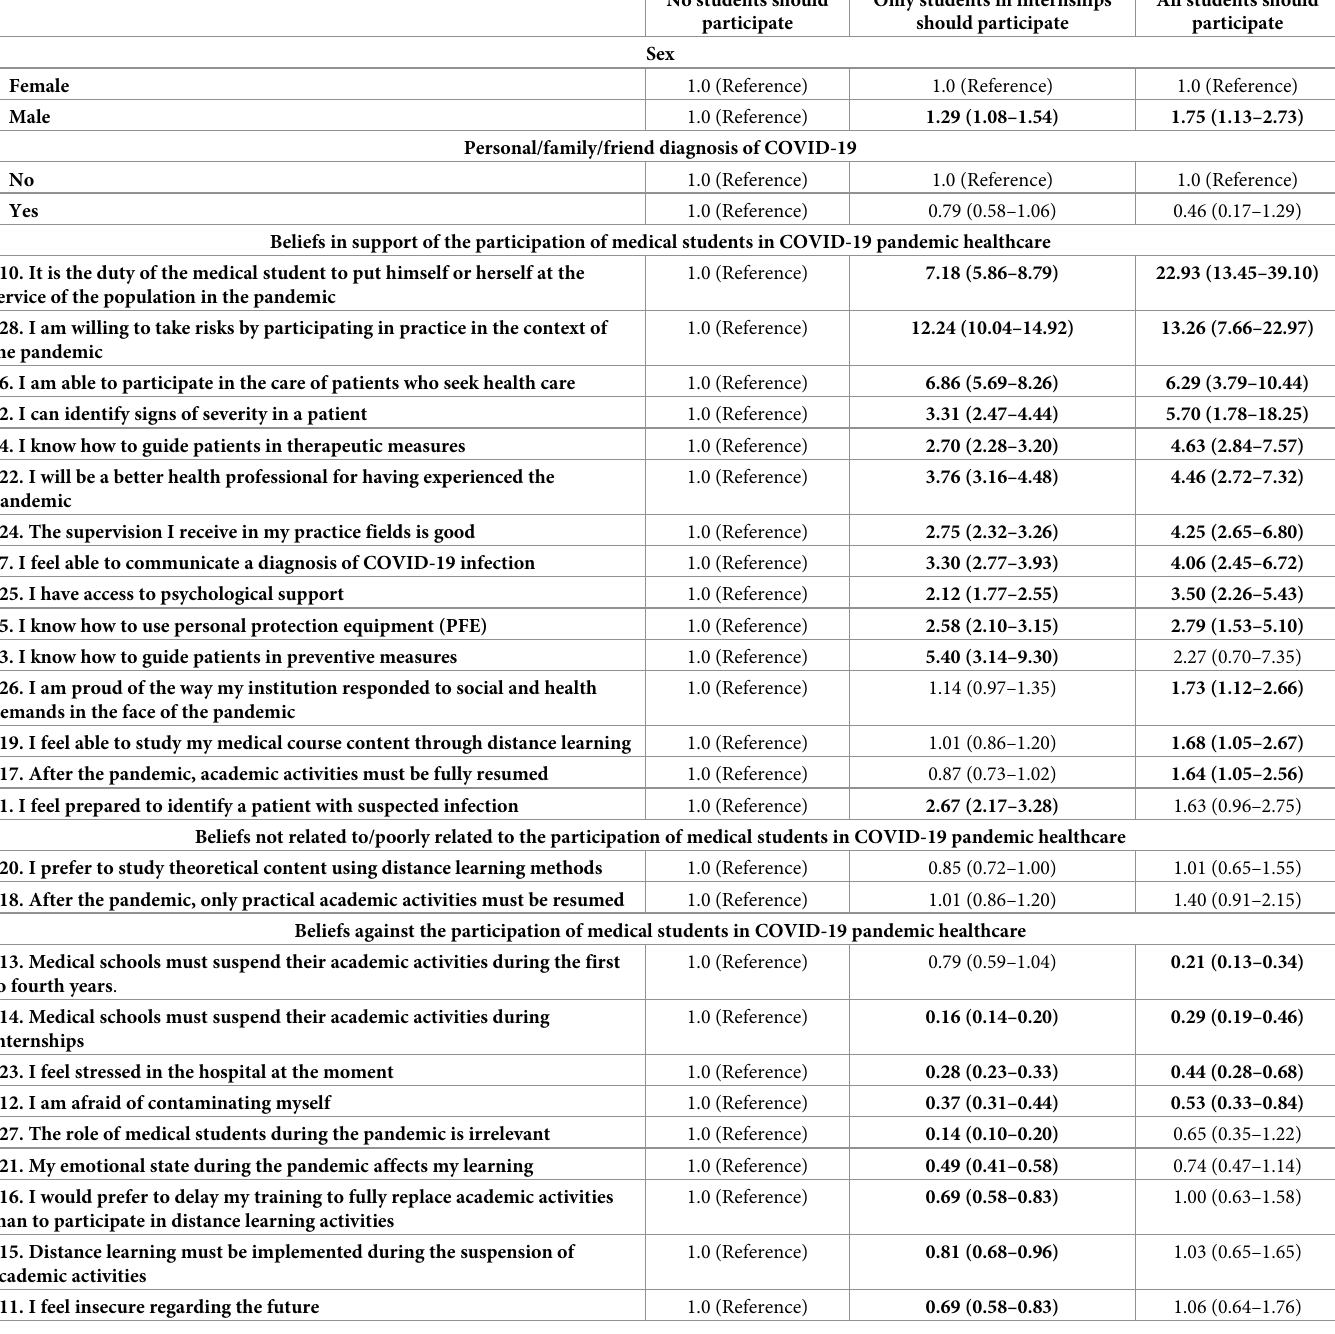
Table 4. Adjusted odds ratios (95% confidence intervals) for the association between internship students’ characteristics and perceptions and their views on the role of medical students during the COVID-19